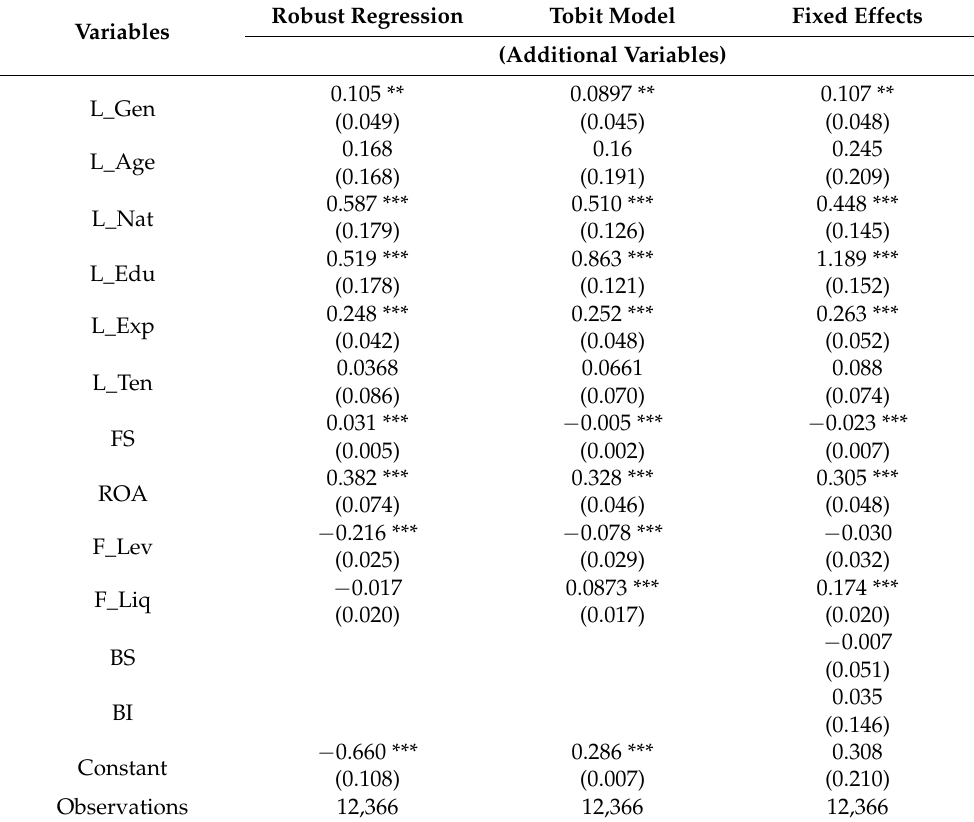
Table 4. The robustness results of the models analyzed. Robust Regression Tobit Model Fixed Variables